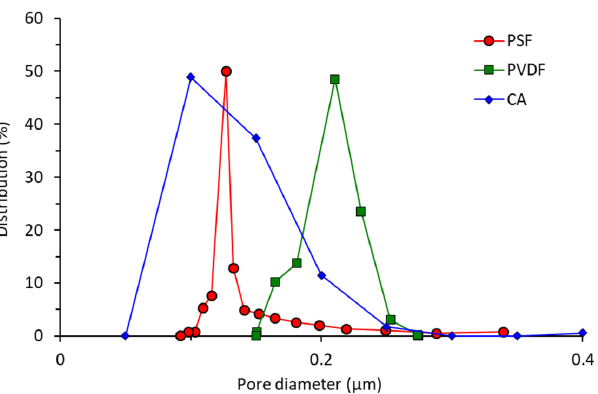
Figure 3. The pore size distribution of the developed cellulose acetate (CA), polysulfone (PSF), and polyvinylidene difluoride (PVDF) membranes.